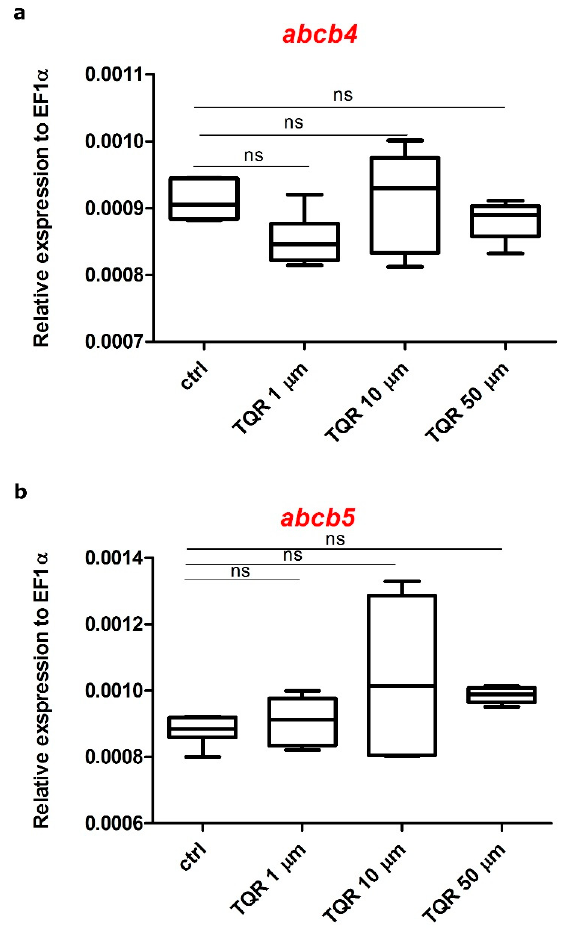
Figure 7. Expression profiles of zebrafish ATP-binding cassette (ABC) transporter family genes. The graphs show pooled data of the mRNA expression of ( a ) abcb4 and ( b ) abcb5 from pooled 56- hour post-fertilization (hpf) wild-type zebrafish larvae ( n = 30) in four experimental groups: 1) control, 2) exposed to TQR 1 µM, 3) exposed to TQR 10 µM, and 4) exposed to TQR 50 µM. Each